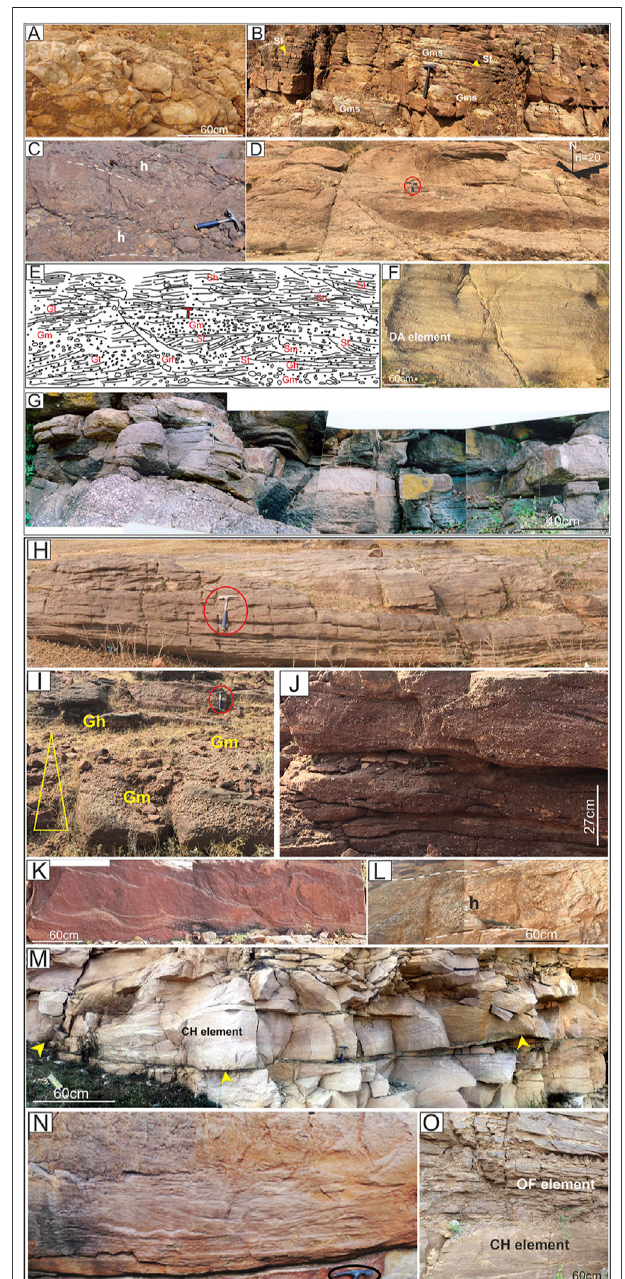
FIGURE 3 | Field photographs showing (A) rock avalanche, (B) alternation between massive, pebbly granular sandstone (Gms) and centimeters-thick fi ne/medium-grained sandstone (Sf) resulting in couplet stratigraphy of sheet fl ood deposit from alluvial fan of Par Formation, Gwalior basin. (C) hyperconcentrated fl ow (h) deposit, (D) ephemeral fl uvial deposit showing mutual disposition of gravel bar and channel elements (E) sketch thereof and (F) downstream accretion element from the Damdama Formation,Bayanabasin. (G) Amalgamated sheetsand(SS)elementfromthe Rehtikhol fl uvial deposit, Singhora basin; note sharp contact with underlying conglomerate. (H) Large-scale trough cross-strati fi cations with